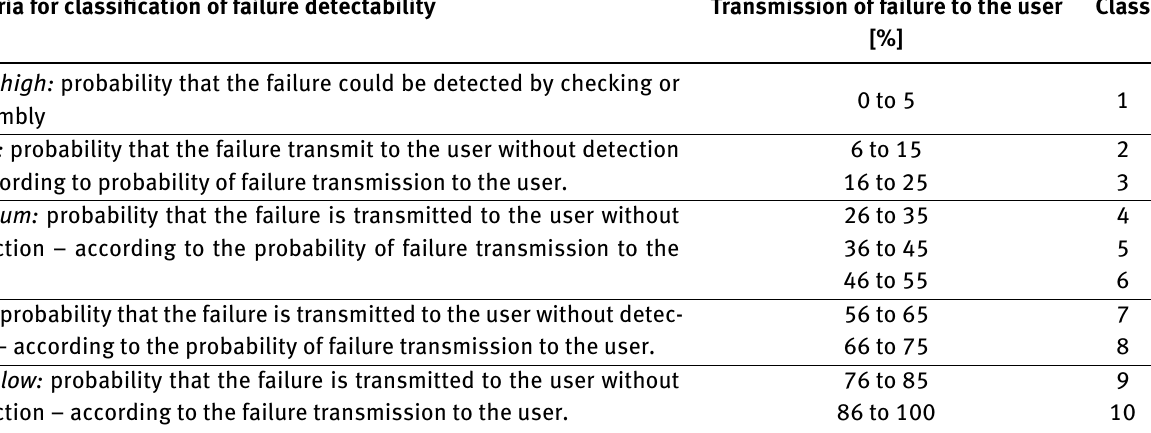
Table 3: Classification of failure detectability Criteria for classification of failure detectability Transmission of failure to the user